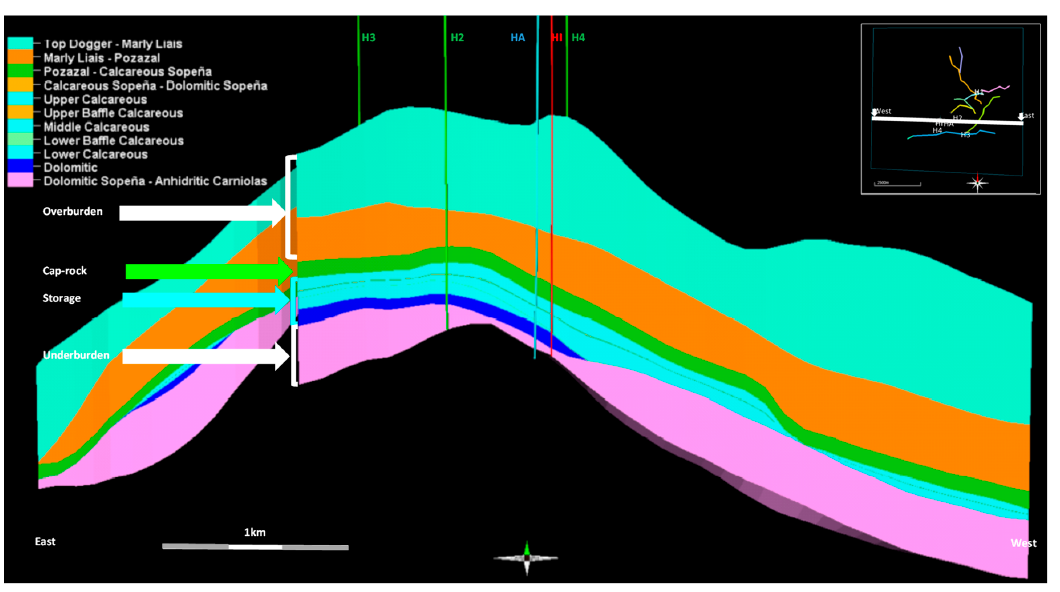
Figure 2. Vertical cross-section of the geological model of the Hontomìn storage complex; The HA and HI newly-drilled wells are the observation and CO 2 injection wells, respectively, while H2 to H4 wells are legacy wells.